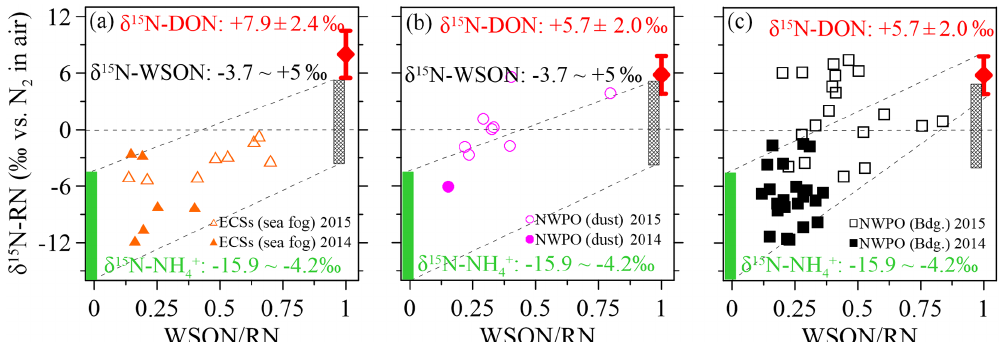
, the grey bar indicates the 4